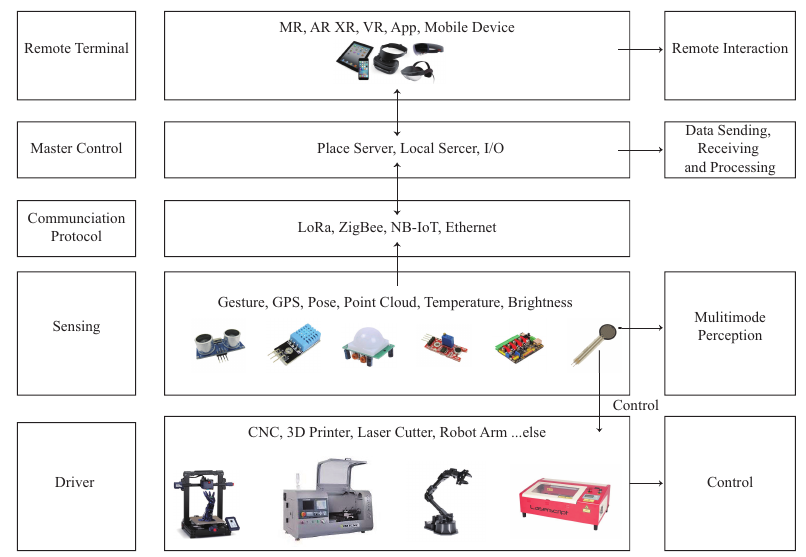
Figure 6. The concept of the architecture design of the SENS+